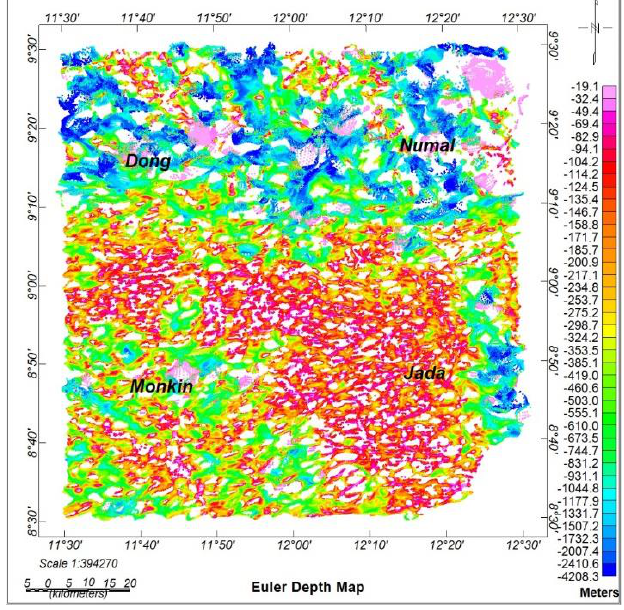
Figure 8: Euler depth map of the study